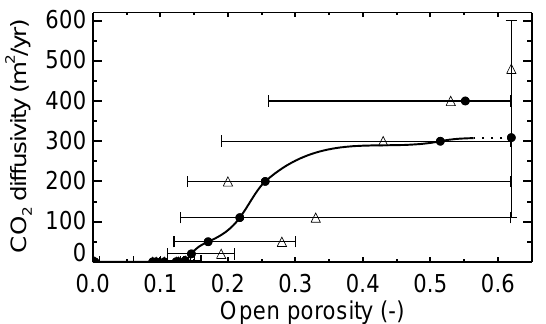
Fig. 1. The error bars show prior ranges for the porosity values (hor- izontal) and surface diffusivity (vertical) estimated with the GA. The solid line shows a monotonic smoothing spline fitted to the filled circles (ignoring the point at 400m 2 yr − 1 because it is greater than the surface diffusivity, see text). The dashed line shows diffu- sivity over the well-mixed layer (not used). The open triangles show a case with points that do not increase monotonically (so would not be tested in the firn